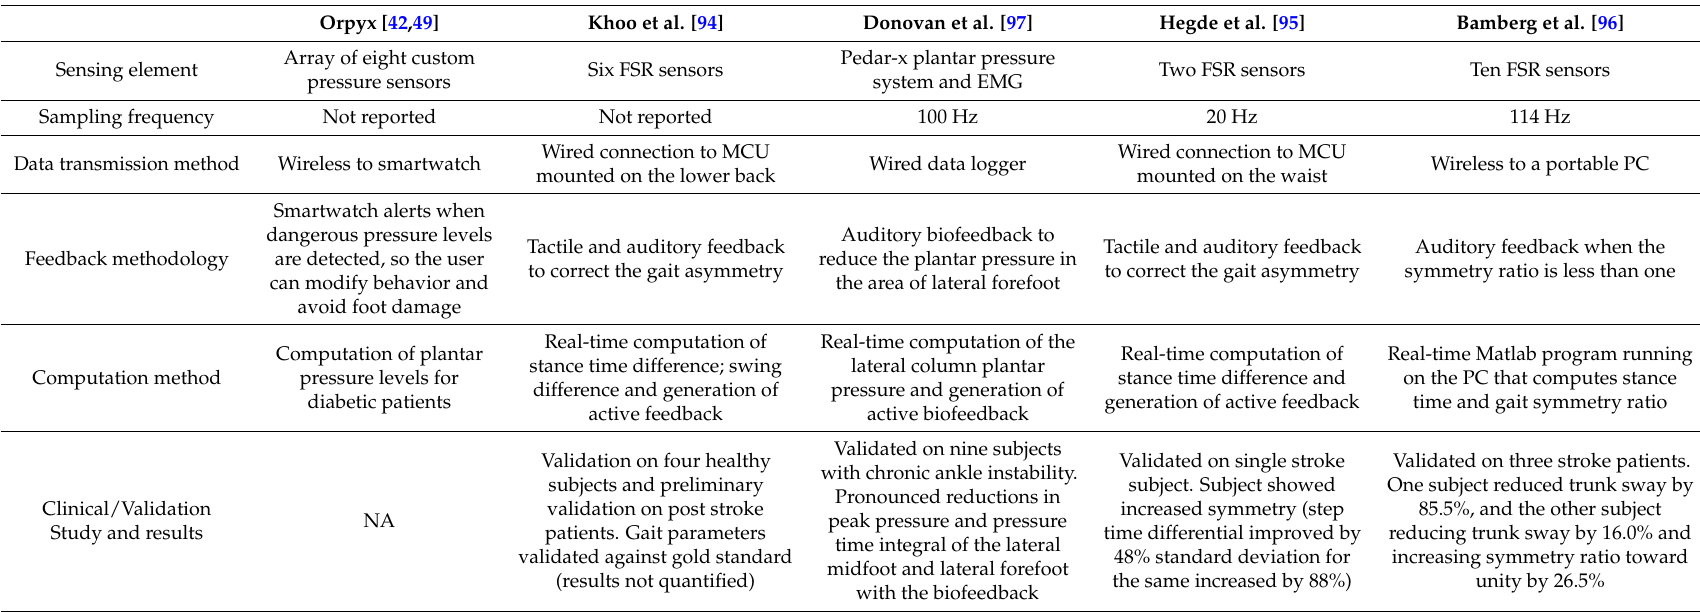
Table 4. Comparison of footwear-based biofeedback